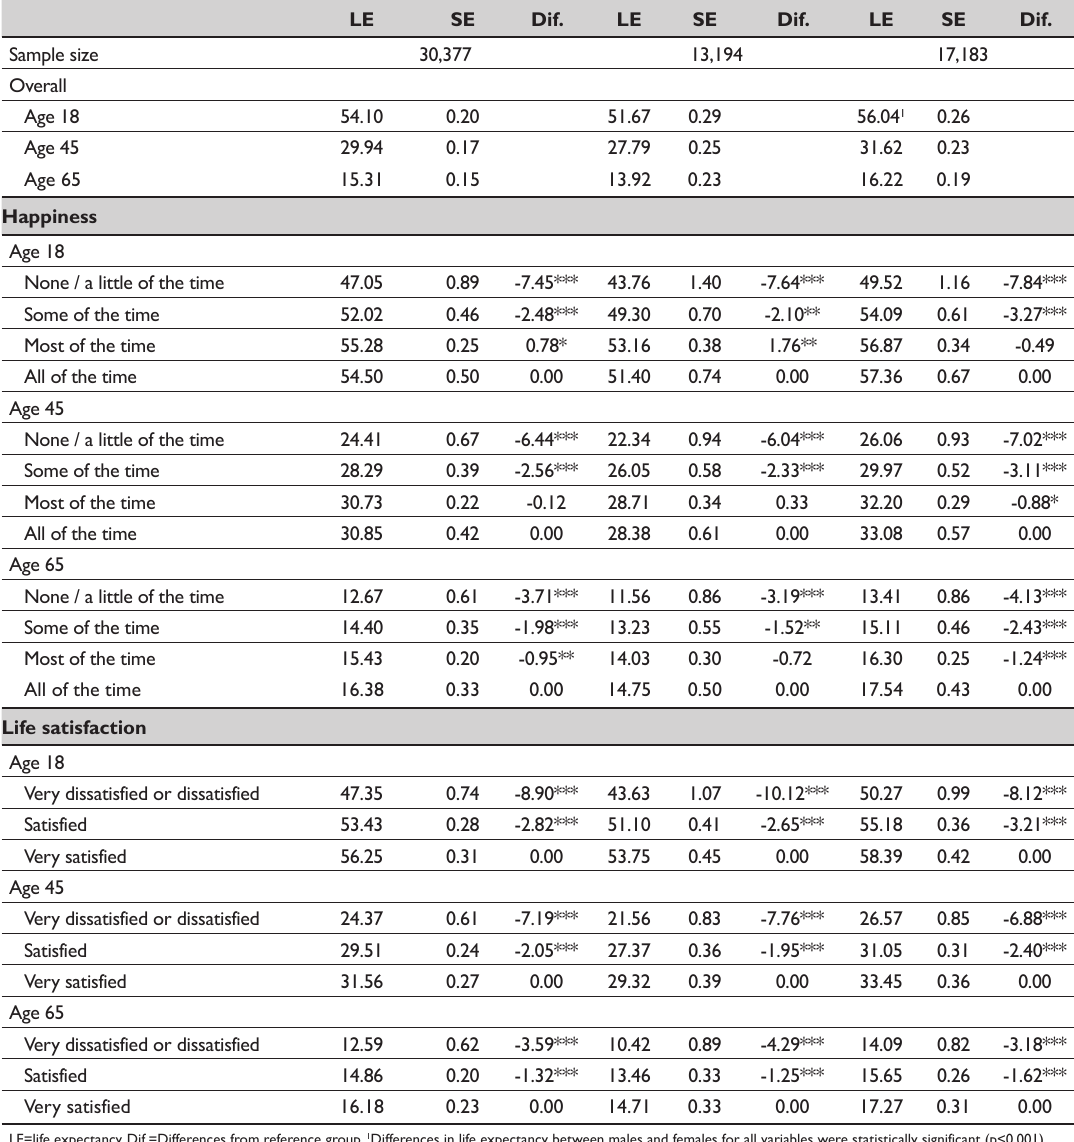
Table 2: Estimated life expectancies at selected ages at baseline, United States, 2001-2014 Happiness/Life Satisfaction Both Sexes Male Female LE SE Dif. LE SE Dif. LE SE Dif.